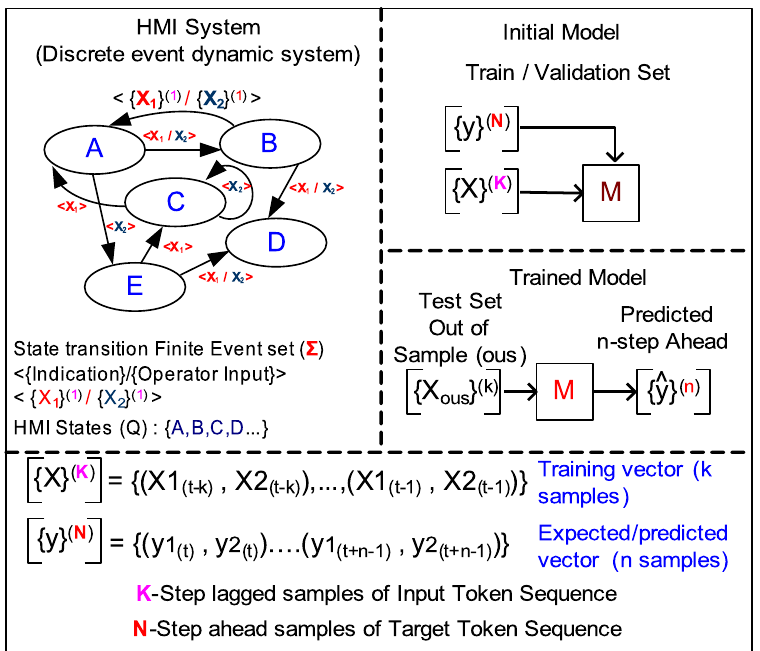
Figure 6. HMI System modelled as a Discrete Event System